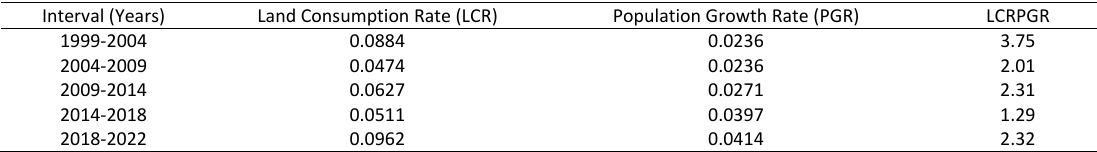
Table 7: The Ratio of Land Consumption Rate and Population Growth Rate.